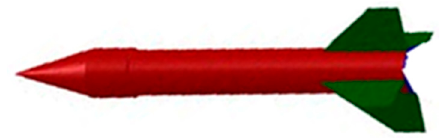
Figure 1. Hypersonic vehicle in the state with fairing.